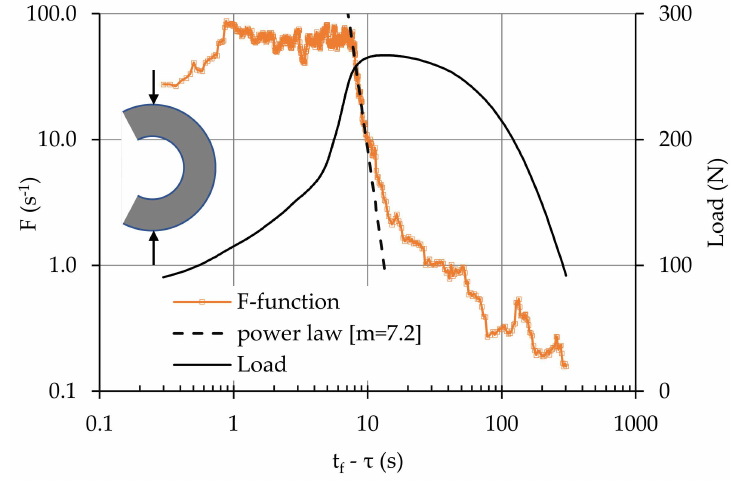
Figure 14. Time variations of the F-function and of the applied load for a typical CSR specimen. In terms of the natural time concept, the temporal variation of the parameters κ 1 , S and S_, for the same CSR specimen, is plotted in Figure 15 against the t f -t parameter along semi-logarithmic scale, together with the respective evolution of the applied load. It can be seen from Figure 15 that a first critical stage is detected at the time interval between t f -t ≈ 100 s until t f -t ≈ 60 s, i.e., about 100 s before macroscopic fracture (yellow-shaded area in Figure 15), with the variance κ 1 crossing and eventually fluctuating around the critical value of 0.070 with both entropies S, S_ remaining lower than S u = 0.0966.